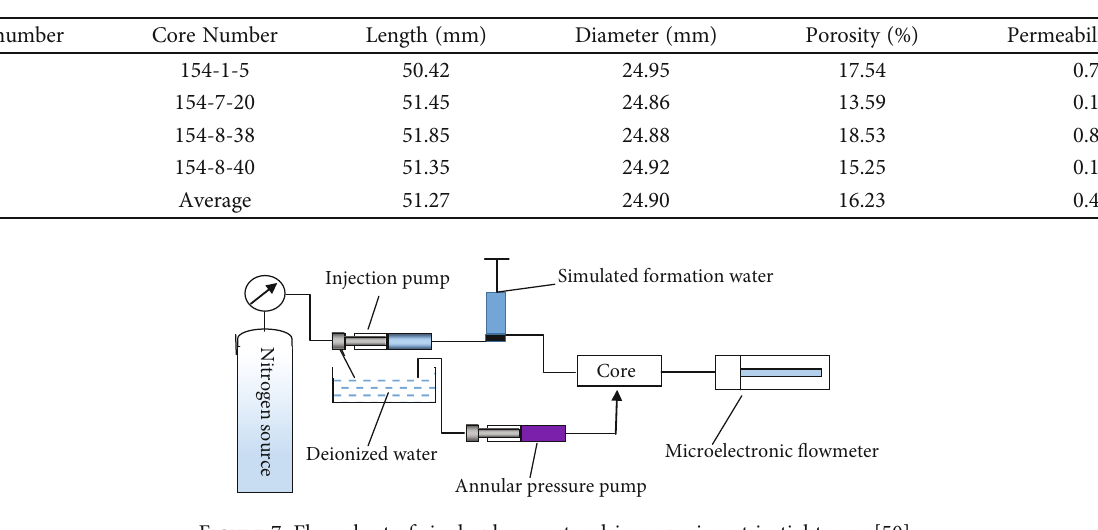
Figure 6: Nonlinear relationship between non-Newtonian parameter n value and micro-nanochannel diameter. Table 3: Basic parameters of the experimental cores (sandstone core).